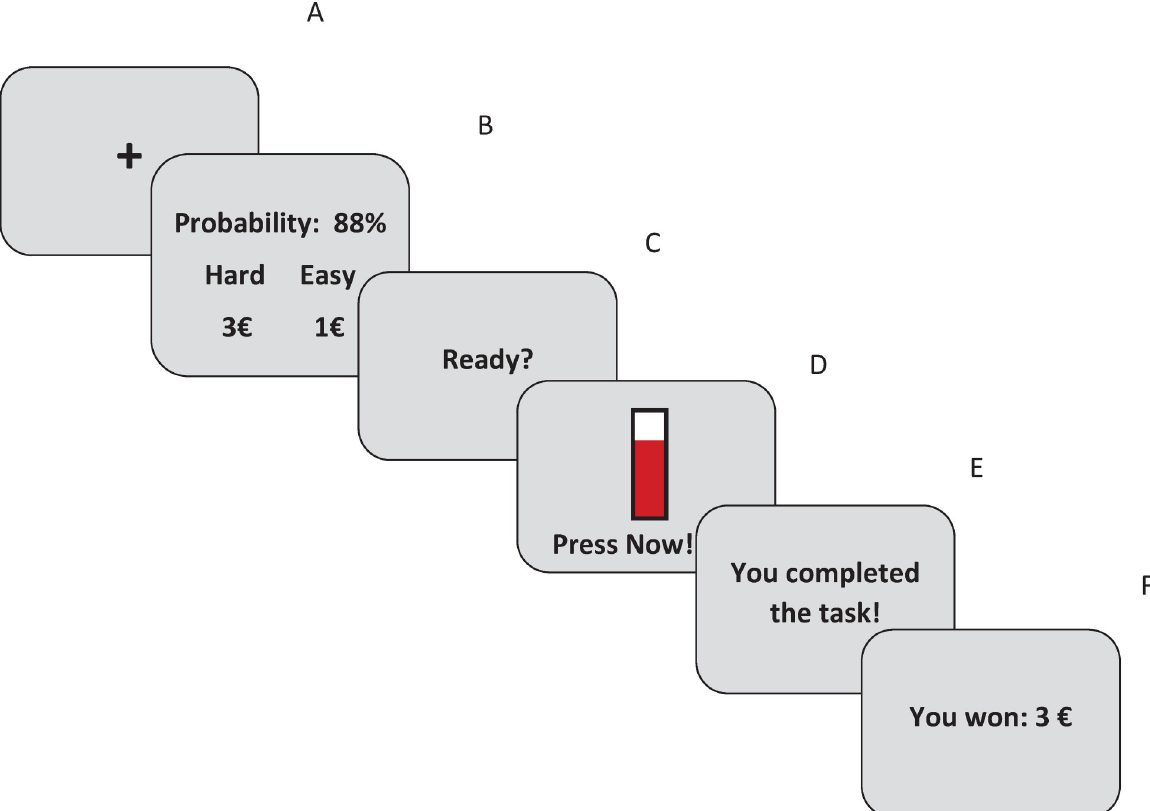
Fig 1. Schematic illustration of one trial of the original EEfRT. A fixation cross (1s, A) is followed by a screen showing probability of reward attainment and reward magnitude for the easy and the hard task (B), lasting until the participant made a choice which task to complete but no longer than 5s. Then, after presentation of a ready–screen (1s, C) the main screen for the trial showing a red bar that fills with each button press is presented until the task is completed or until the trial time is over (D). Finally, task completion is signaled (2s, E) and a feedback screen shows the amount of money won (2s,